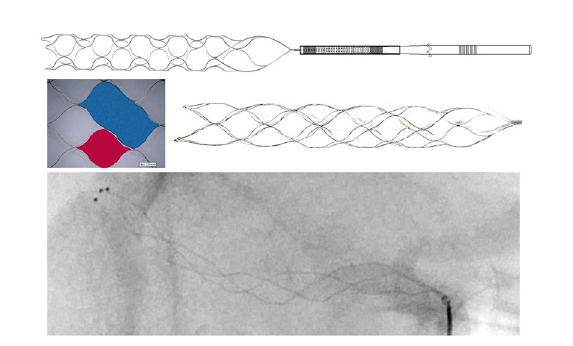
FIGURE1 There are three radiopaque marks at the distal end of the Neurohawk retriever. And three radiopaque wires twined around the entire struts. The useable section of the Neurohawk retriever is composed of large cells (blue area) and small cells (red